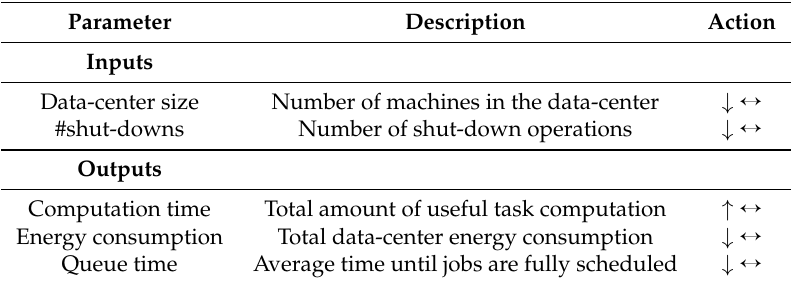
Table 1. DEA inputs and outputs. Action column arrows mean whether the input/output value may be decreased (down arrow), increased (up arrow) or kept